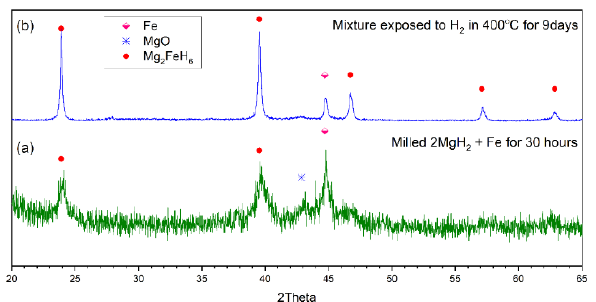
Figure 2. XRD pattern (Cu K- α ) of the sample ( a ) milled for 1 day and 6 h, and ( b ) exposed to hydrogen at 400 °C for 9 days.